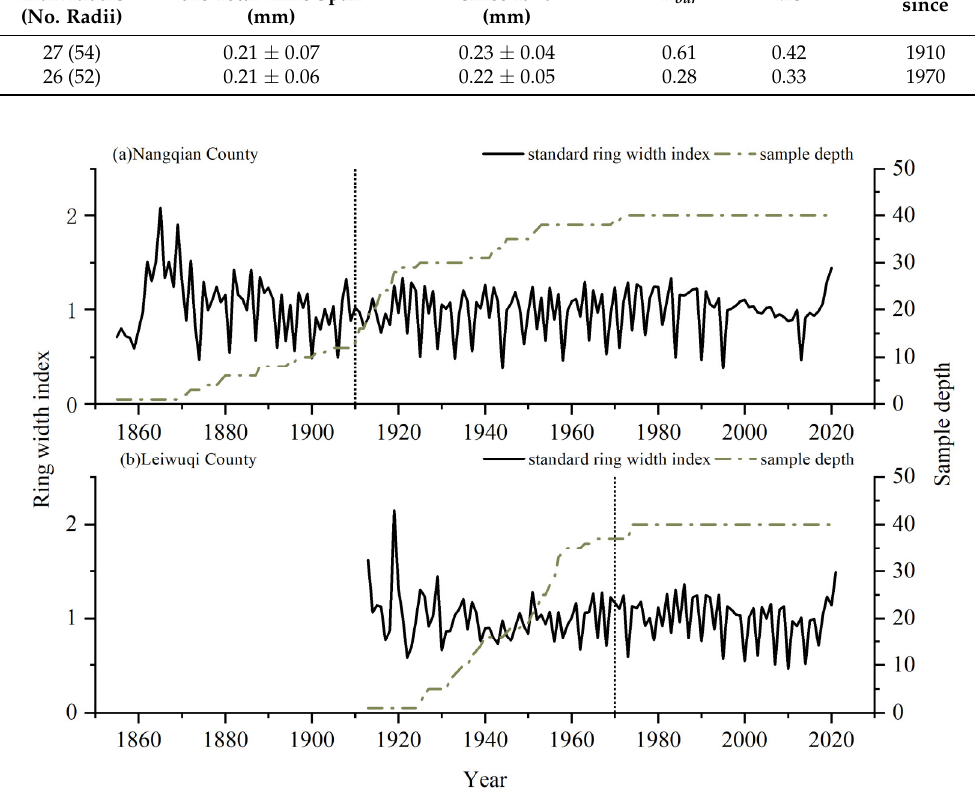
Figure 3. Variations of the standard ring-width index (solid lines) of R. przewalskii shrubs at the two study sites (( a ) NQ; ( b ) LWQ). The sampled depth (dashed lines) is shown in the right y-axis. Vertical dashed lines denote the year with EPS > 0.85.